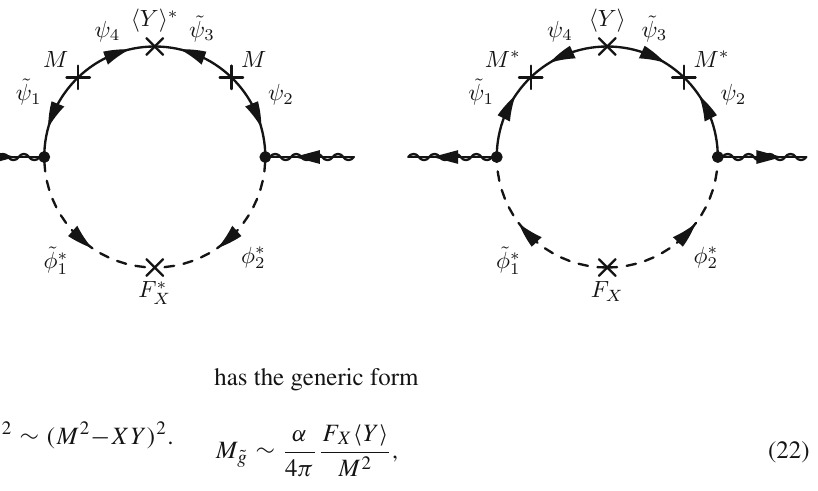
Fig. 7 One-loop diagrams for the gaugino mass from the example model (17), with R-charge conservation at every vertices. Diagrams on the left and right are conjugate to each other, and both should be included as Majorana mass